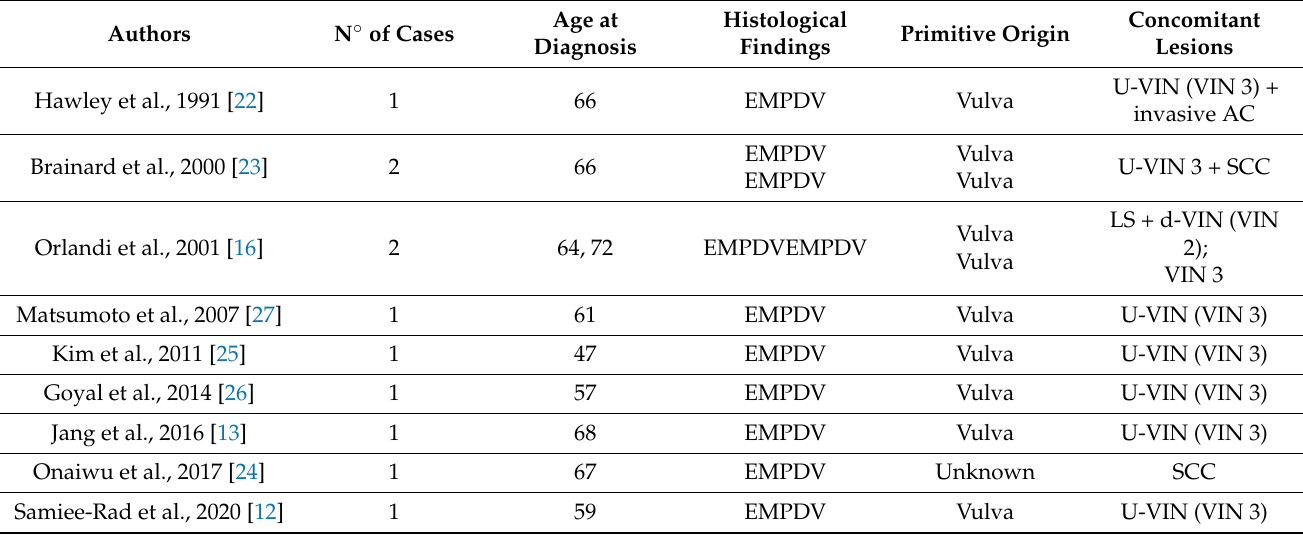
Table 3. EMPDV associated with one or more concomitant premalignant and/or malignant vulvar lesions (literature